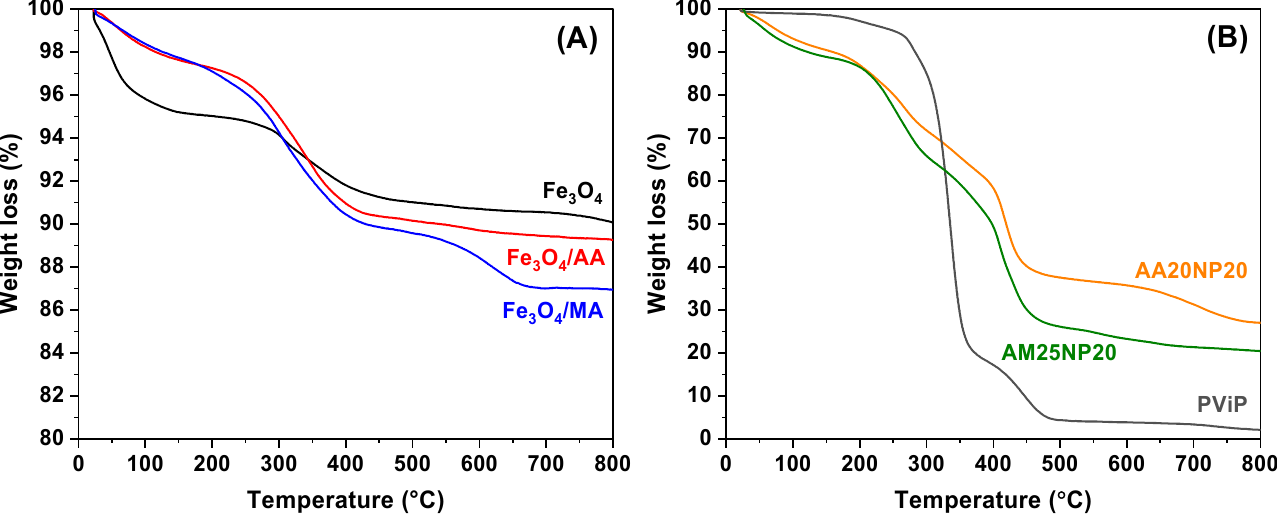
Figure 4. Thermogravimetry analysis: ( A ) pure (Fe 3 O 4 )-, acrylic acid (Fe 3 O 4 /AA)-, and methacrylic acid (Fe 3 O 4 /AM)-functionalized Fe 3 O 4 ; ( B ) magneto-polymers (i.e., AM25NP20 and AA20NP20) and poly(vinyl pivalate) (PViP).